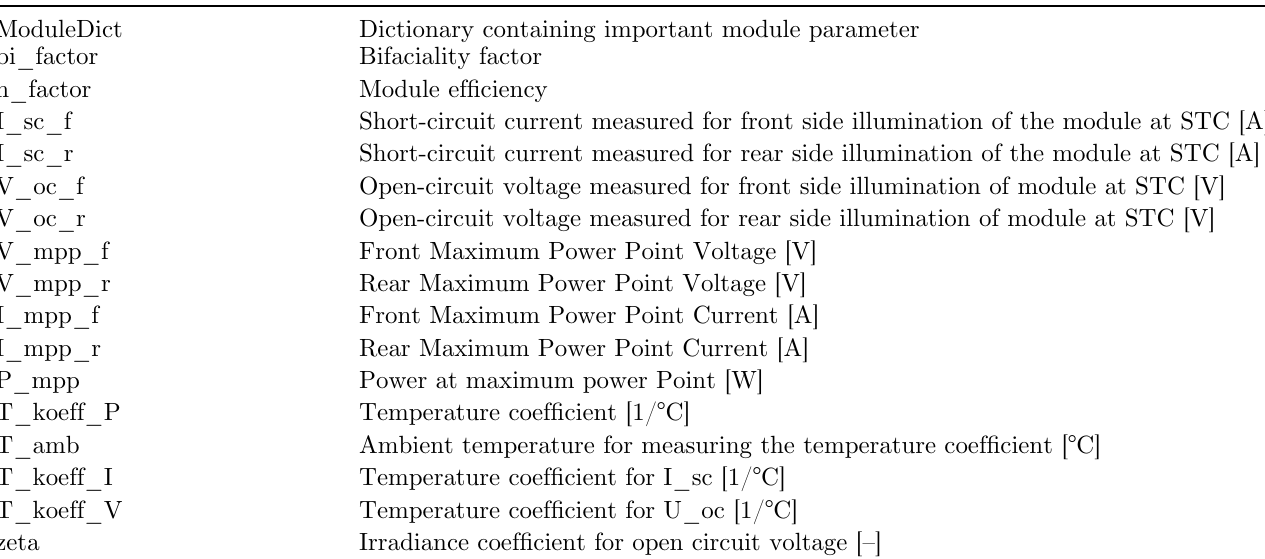
Table 3. The module dictionary encompasses all the relevant data of the bifacial PV module, which is relevant for the electrical simulation. In case that there is no rear module data speci fi ed by the manufacturer, a simpli fi ed electrical simulation approach may be applied